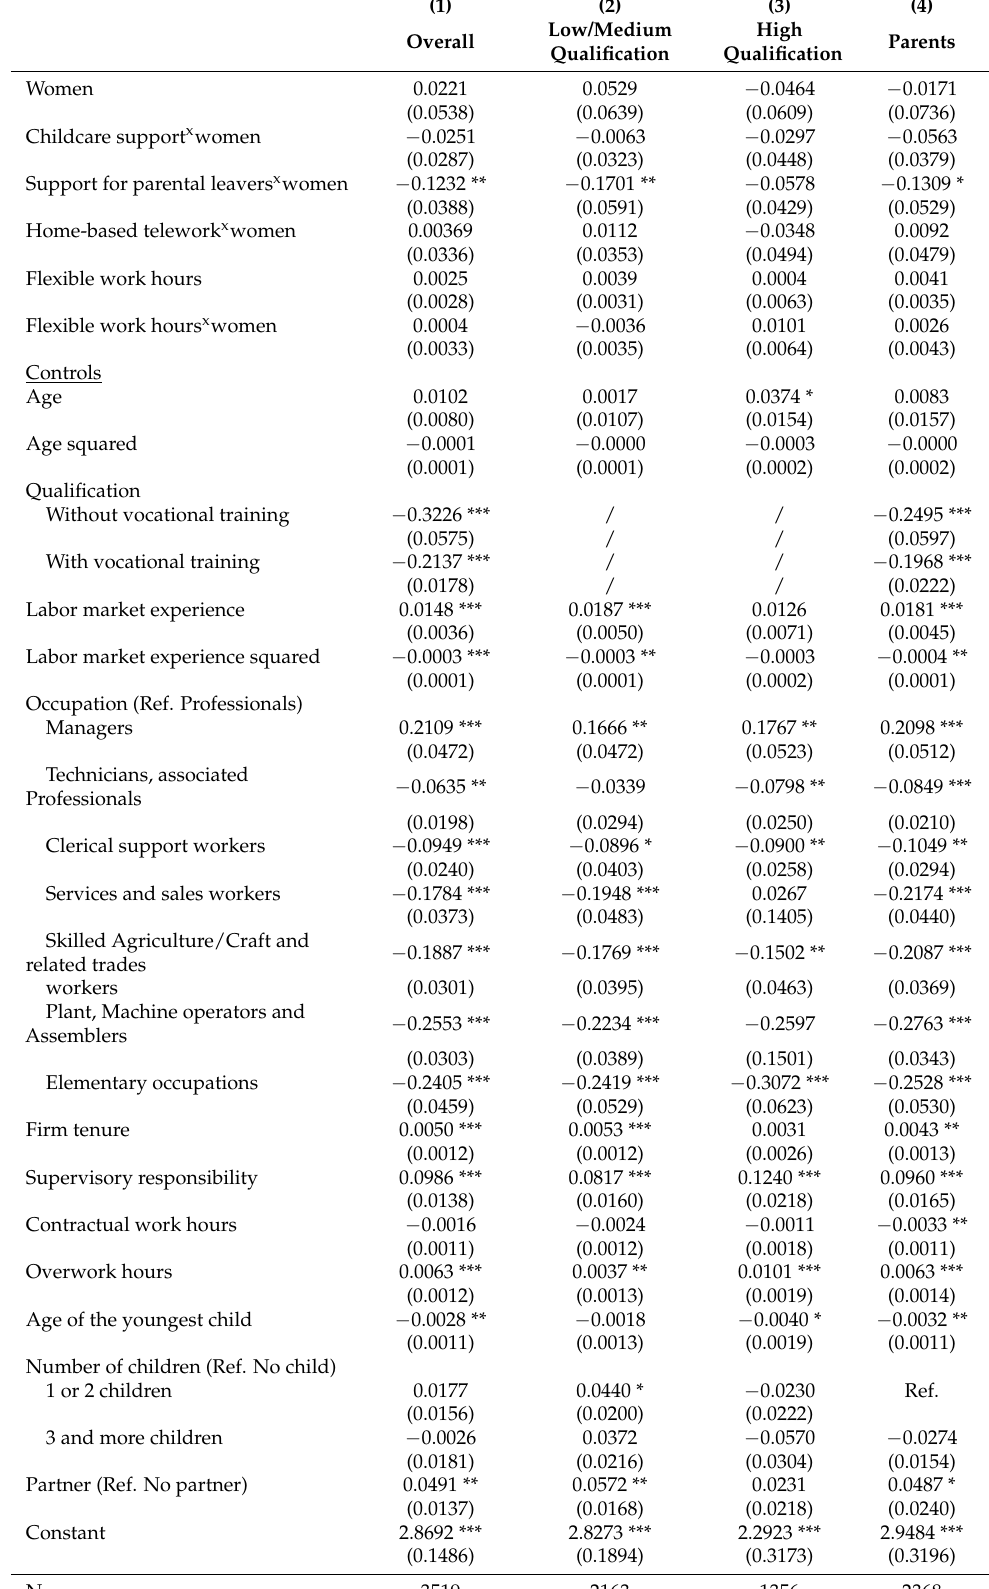
Table A12. The association of WLM and log hourly wages within establishments with at least one EQM, including controls (extended version of Table 5, step